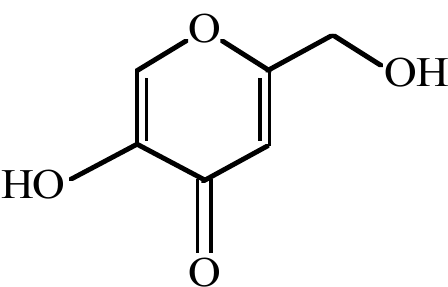
Figure 1. Structure of kojic acid